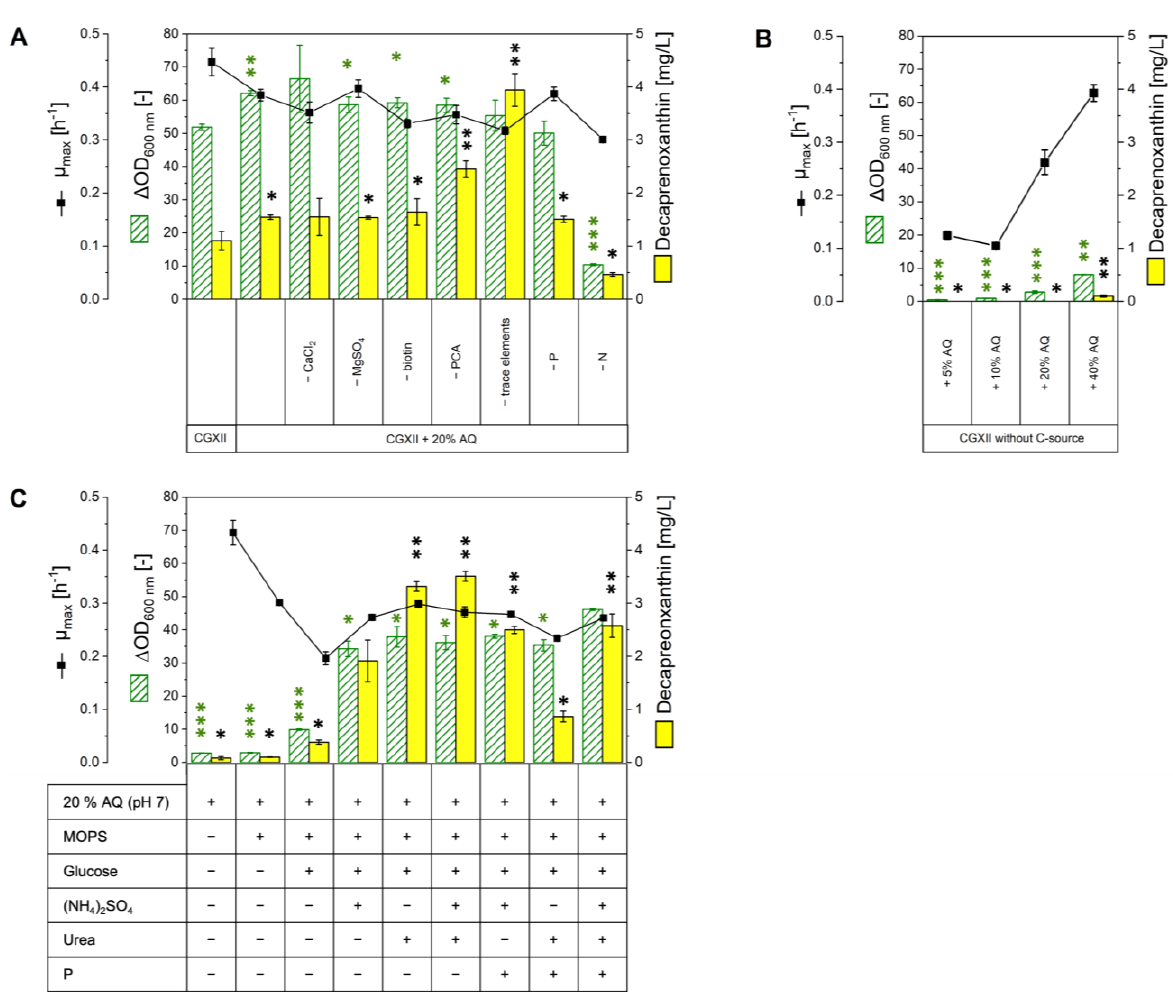
Figure 3. Growth of C. glutamicum WT in AQ containing media. ∆ OD 600 nm , µ max, and decaprenoxanthin production after 48 h of C. glutamicum WT grown in a Biolector ® flowerplate microcultivation system. The maximal OD 600 nm difference from the initial OD 600 nm during 48 h of cultivation is given as ∆ OD 600 nm . Values and error bars represent means and standard deviations of triplicate cultiva- tions. Statistical significance in comparison to the cultivation in CGXII medium was assessed for ∆ OD 600 nm (marked in green) and decaprenoxanthin production (marked in black) in Student’s t -test (*** p < 0.0001, ** p < 0.001, * p < 0.05). ( A ) Growth on CGXII, CGXII with addition of 20% ( v / v ) AQ and CGXII with 20% ( v / v ) AQ replacing media components of the CGXII composition. ( B ) Growth on CGXII without carbon source, 5 to 40% ( v / v ) AQ were supplemented as replacement. ( C ) Growth on AQ as the sole medium component, with adjustment to pH 7 and the addition of MOPS buffer, glucose, (NH 4 ) 2 SO 4 , and/or urea and phosphorous source (P). The last column represents the AQ based medium